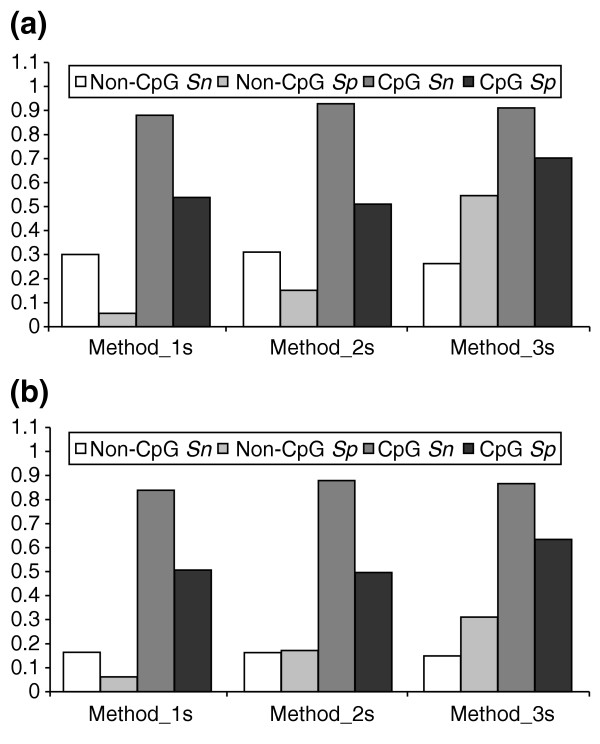
Sensitivity and specificity of promoter prediction for CpG-island related and non-CpG-island related promoters in different gene sets. (a) 5,893 human genes with homologous rodent promoters. (b) All 8,949 human genes in the test set. The definition of different methods is described in the text and in Materials and methods.